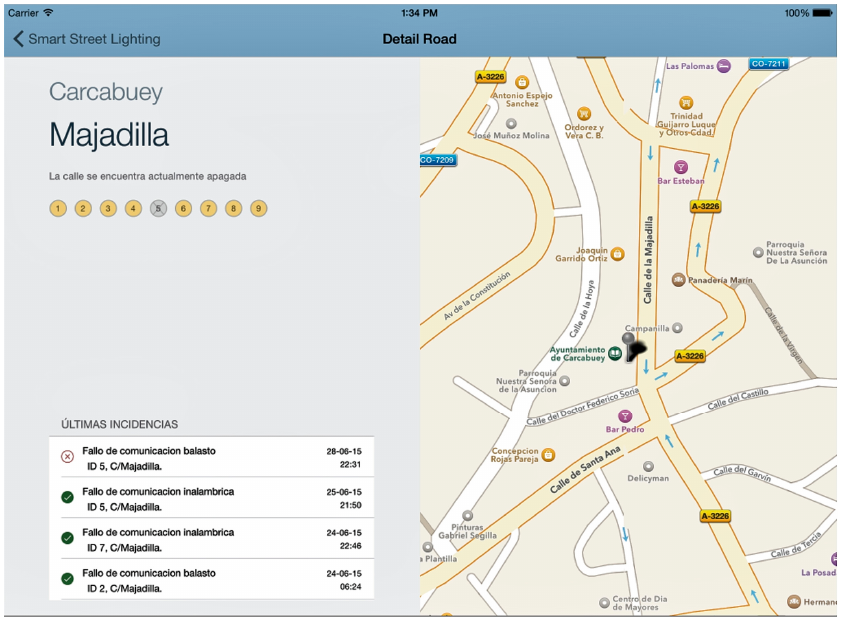
Figure 8. App screenshot GIS location of an incident.